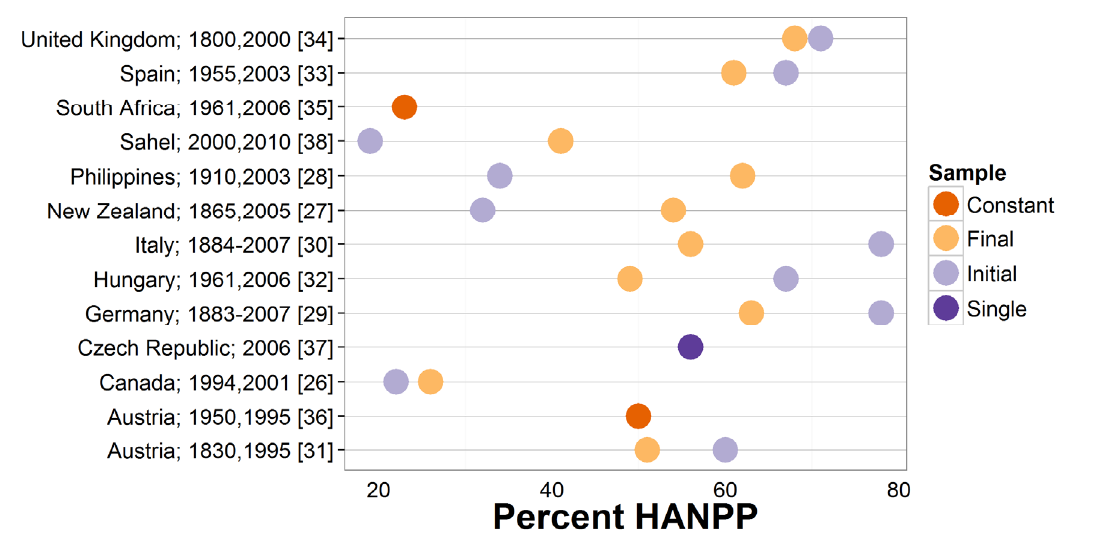
Figure 1. Range in aboveground HANPP over time reported by studies at regional to national scales. Some studies only have HANPP for a single year. For studies with temporal variation, only initial and final HANPP are